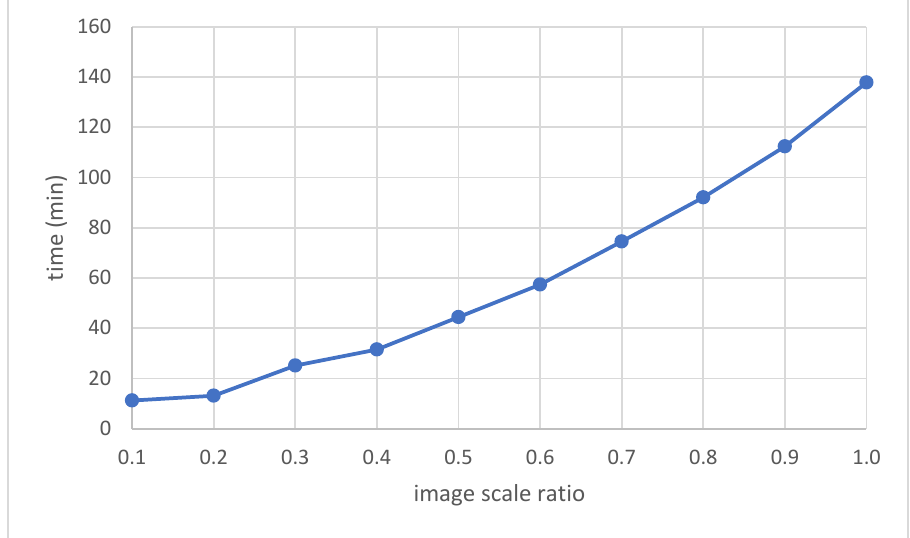
Figure 9. Processing time according to the image size.